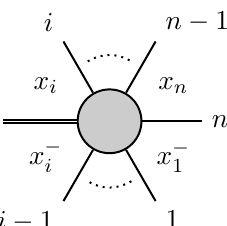
(cid:17) x i (cid:0) q i